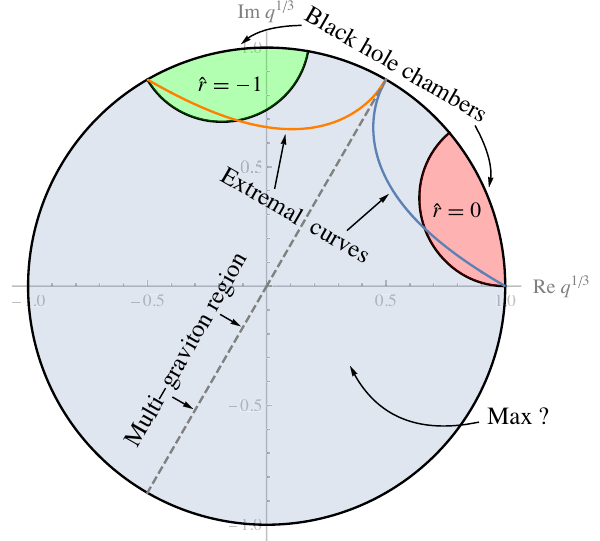
FIG. 4. Stokes lines in the q plane, where the variable is q 1 = 3 . The notation is the same as in Fig. 3. The dashed line indicates the subspace where both fugacities q and y are real and the computation of Ref. [30], which reproduced the index of multi- graviton states,